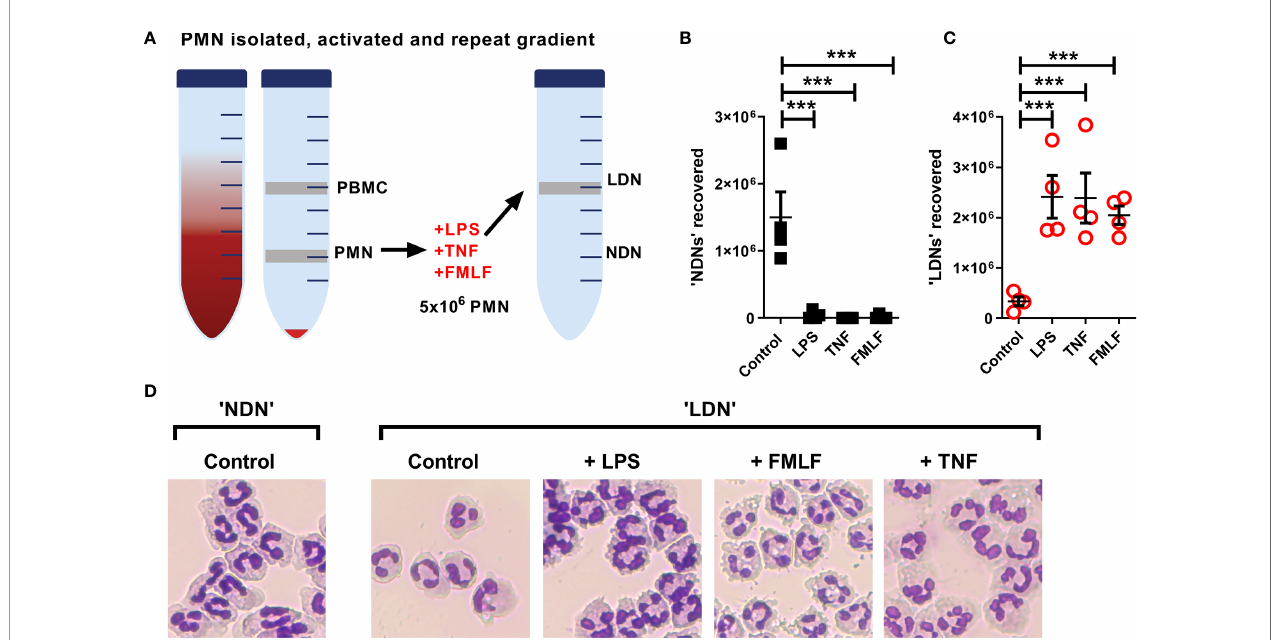
FIGURE 5 | NDNs become LDNs upon activation with in fl ammatory stimuli. (A) Diagram of method. PMN isolated by traditional methods are activated in vitro with in fl ammatory stimuli and then undergo repeat Percoll gradient. (B) Number of neutrophils recovered from the ‘ PMN/NDN ’ layer after second Percoll gradient. (N=4) (C) Number of neutrophils recovered from the ‘ PBMC/LDN ’ layer after second Percoll gradient. (N=4) (D) Representative cytospin images of neutrophils recovered in each condition. Statistical analysis by One-way ANOVA with multiple comparisons where ***p ≤